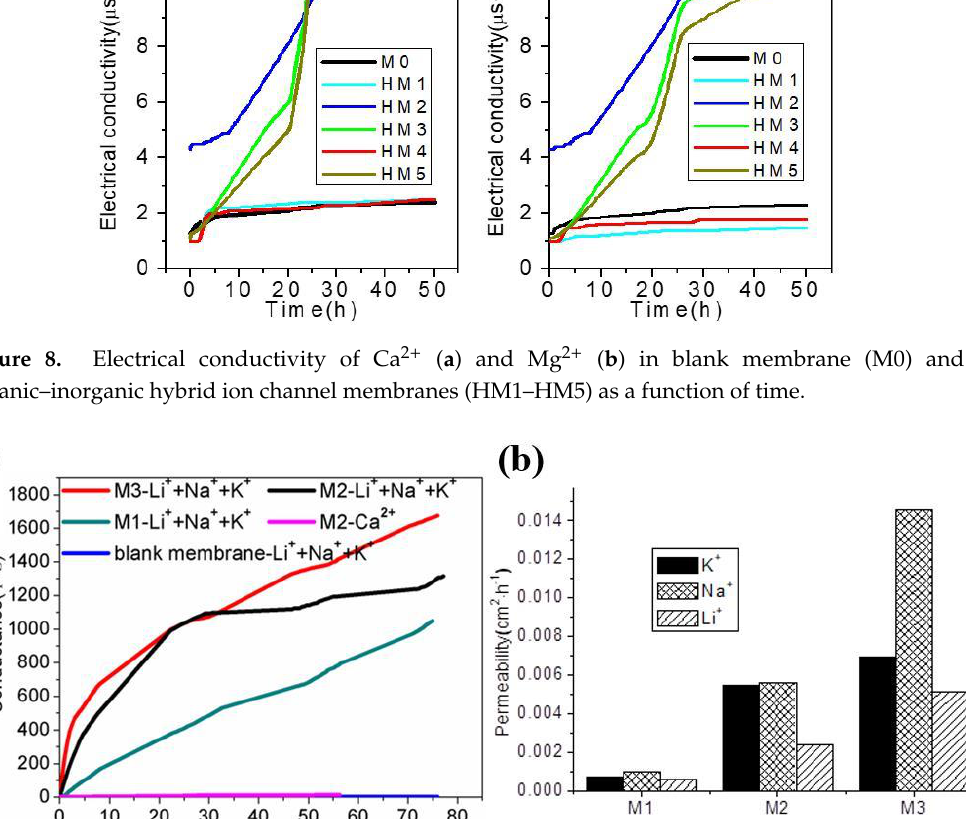
Figure 9. ( a ) Conductance profiles in the strip phase as a function of time; ( b ) permeability values of Li + , Na + , and K + cations in the M1, M2, and M3 hybrid membranes.